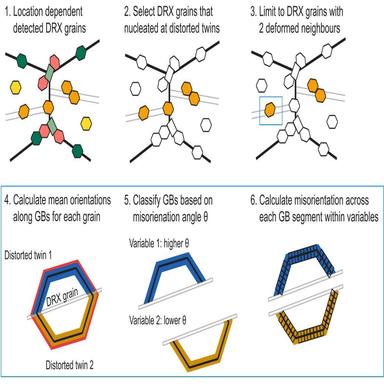
Schematic of the methodology used to analyse the GB misorientation of recrystallised grains that nucleated at distorted twins.